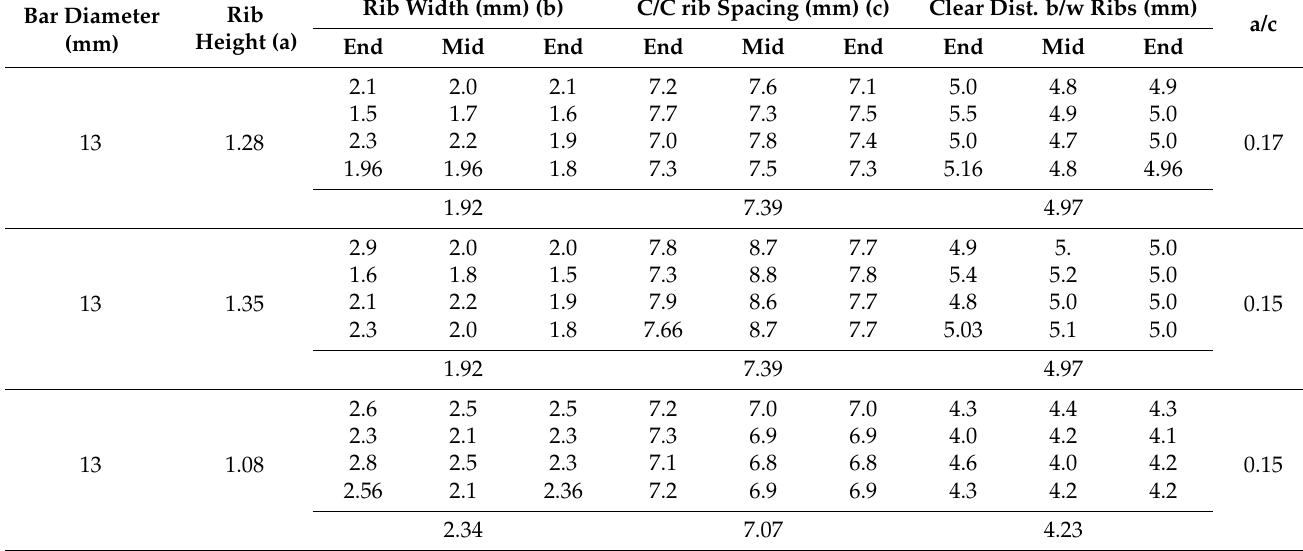
Table 4. Typical geometrical properties for the rebar used ( α = rib angle ≈ 65 ◦ ).